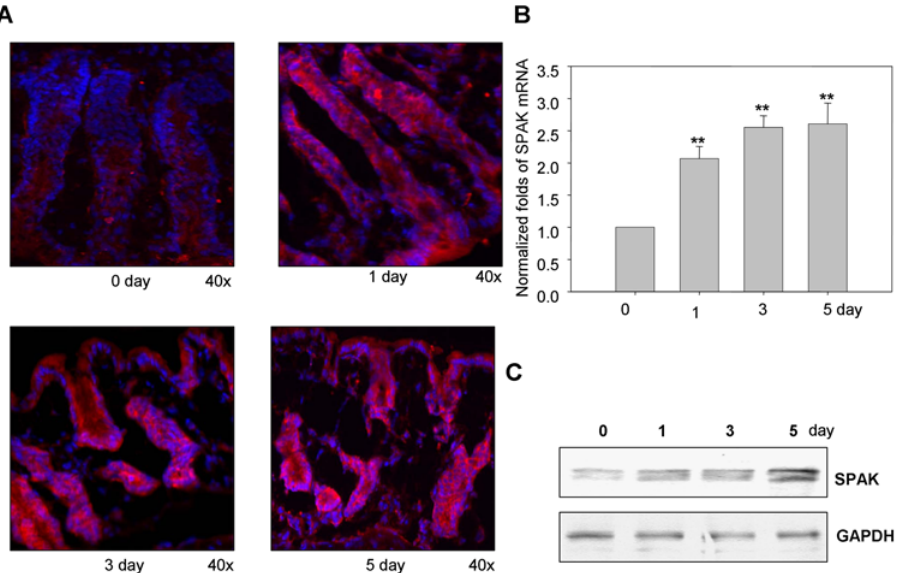
Figure 2. SPAK expression profile in colon tissue from mice treated with hyperosmolarity. A. Immunostaining of SPAK in colon sections of mice treated with hyperosmolarity at 0, 1, 3, and 5 days. SPAK (red); nuclear staining by DAPI (blue). B. Real time PCR analysis of SPAK mRNA expression in mucosa from colon tissue of hyperosmolarity treated mice. ** p , 0.01. C. Western blot analysis of SPAK (upper part) expression in mucosa from colon tissue of hyperosmolarity treated mice, with GAPDH as the internal loading